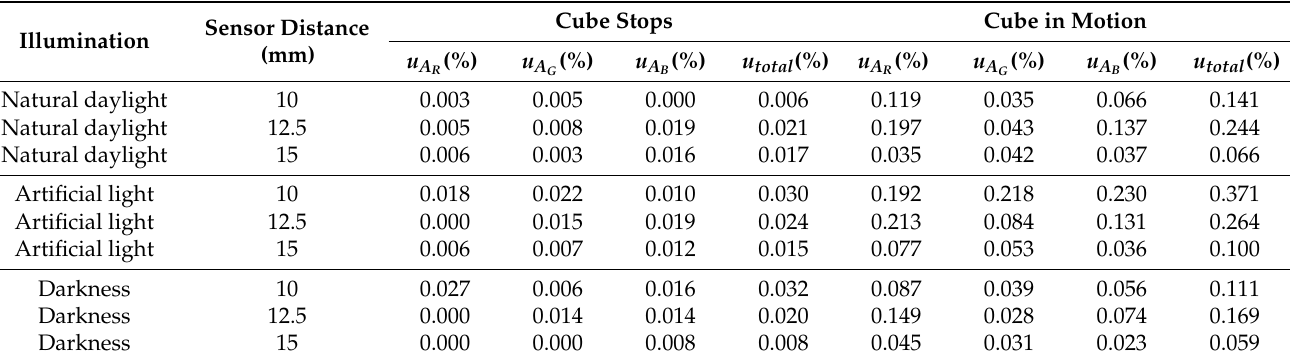
Table 6. Type A standard uncertainty for a pink cube.